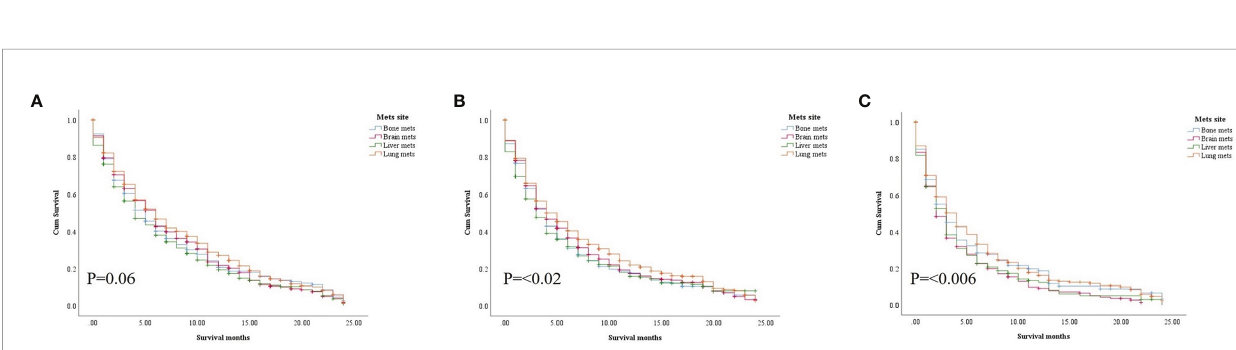
FIGURE 4 | Survival pattern of the presence of metastatic sites in each age group of the ICI era. (A) First age group, 20 – 59 years. (B) Second age group, 60 – 74 years. (C) Third age group, >74